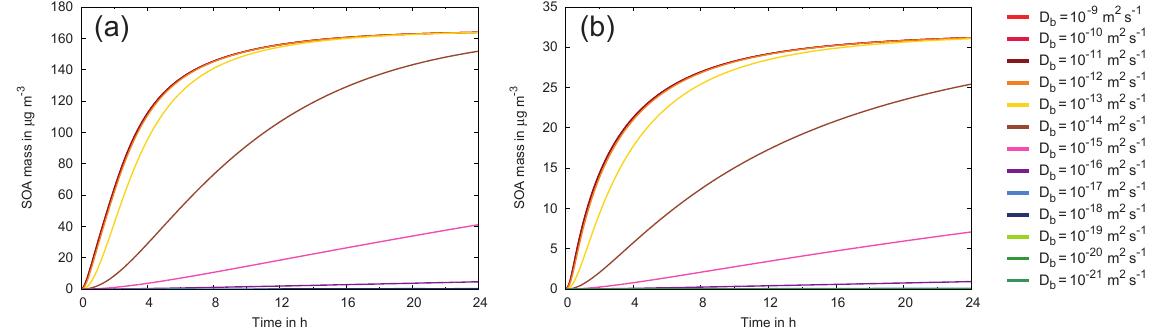
Figure 1. Simulated SOA mass for different particle-phase bulk diffusion coefficients in the range of D b : 10 − 9 –10 − 21 m 2 s − 1 (model case 1 of Table 1) using a particle reaction rate constant of (a) k c = 1s − 1 and (b) k c = 10 − 6 s − 1 .